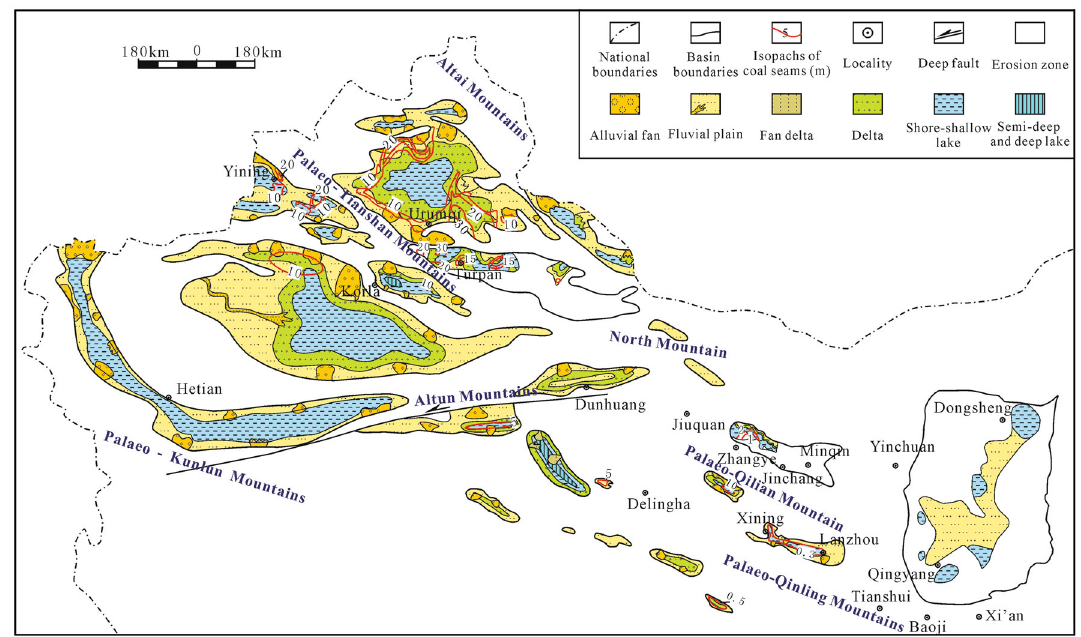
Fig. 13 Paleogeography and distribution of coal seams of SQ1 of the Early-Middle Jurassic in the North China CAA and Northwest